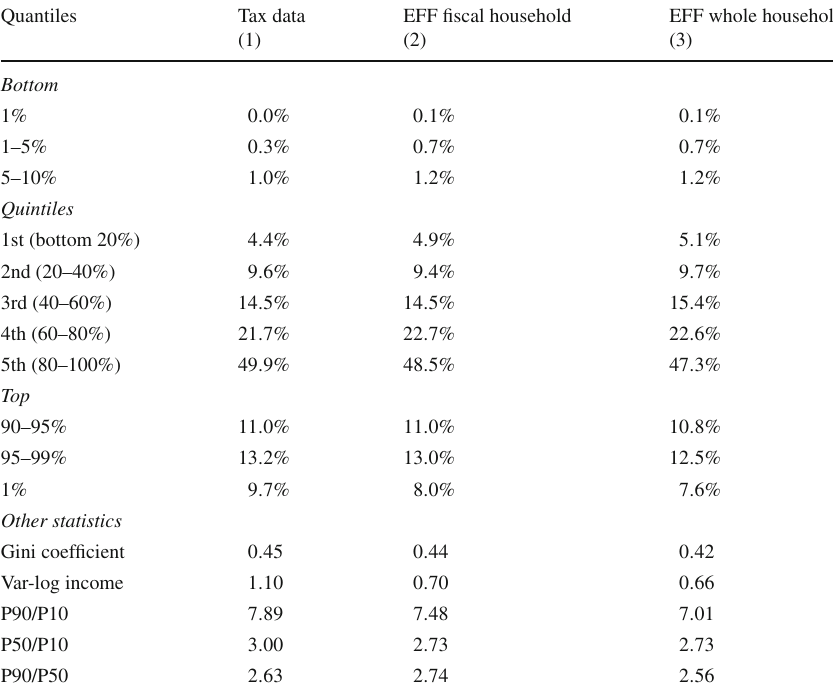
Table 6 Household income distribution: tax data compared to EFF (2013)